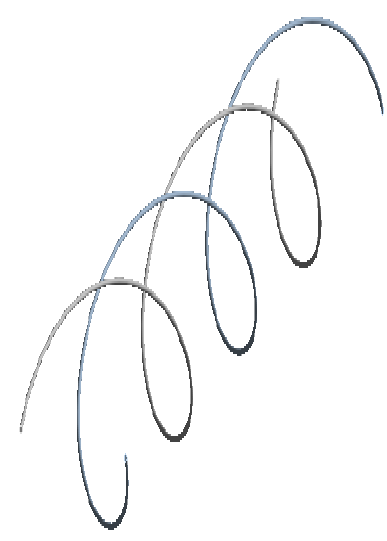
Figure 13. Helical arrangement FOS.